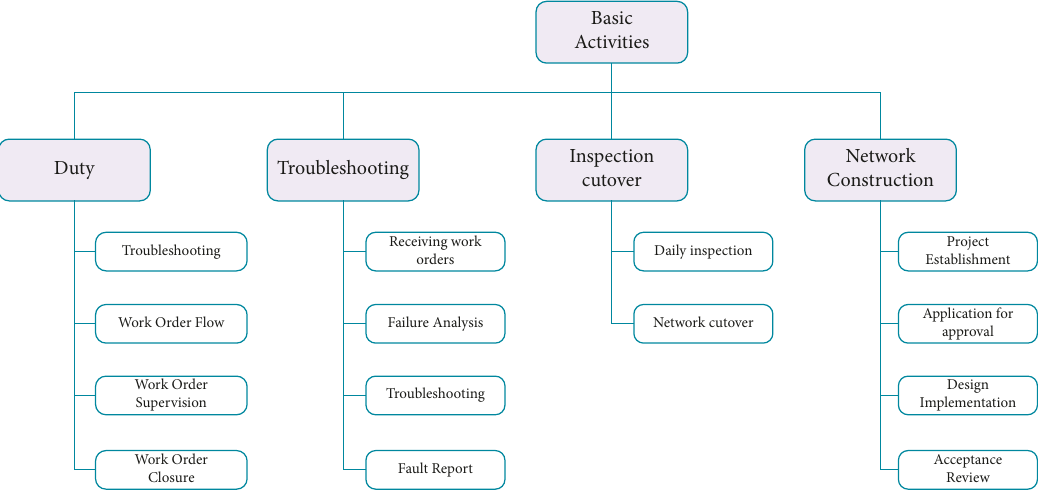
Figure 6: Enterprise Workflow